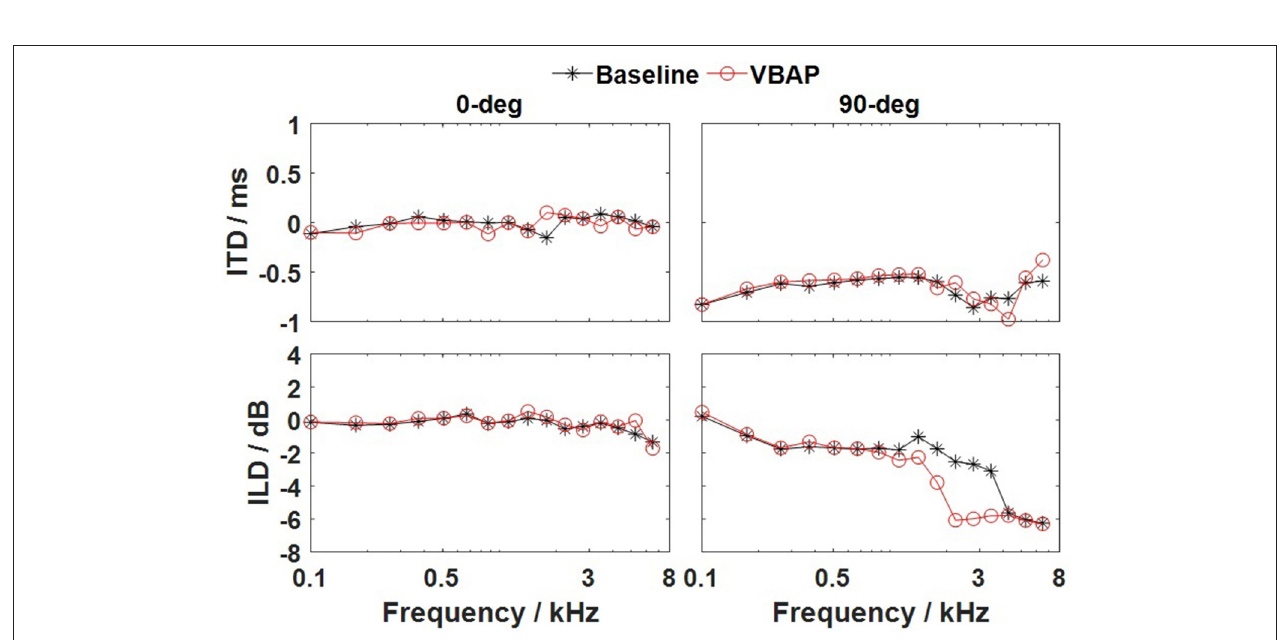
FIGURE 5 | ITDs and ILDs as a function of the critical bands for the baseline method (solid line marked with the black star) and the VBAP method (solid line marked with the red circle). Left column, 0 ◦ azimuth of incidence; and the right column, 90 ◦ azimuth of incidence. The top and bottom rows show the results for the ITDs and ILDs,